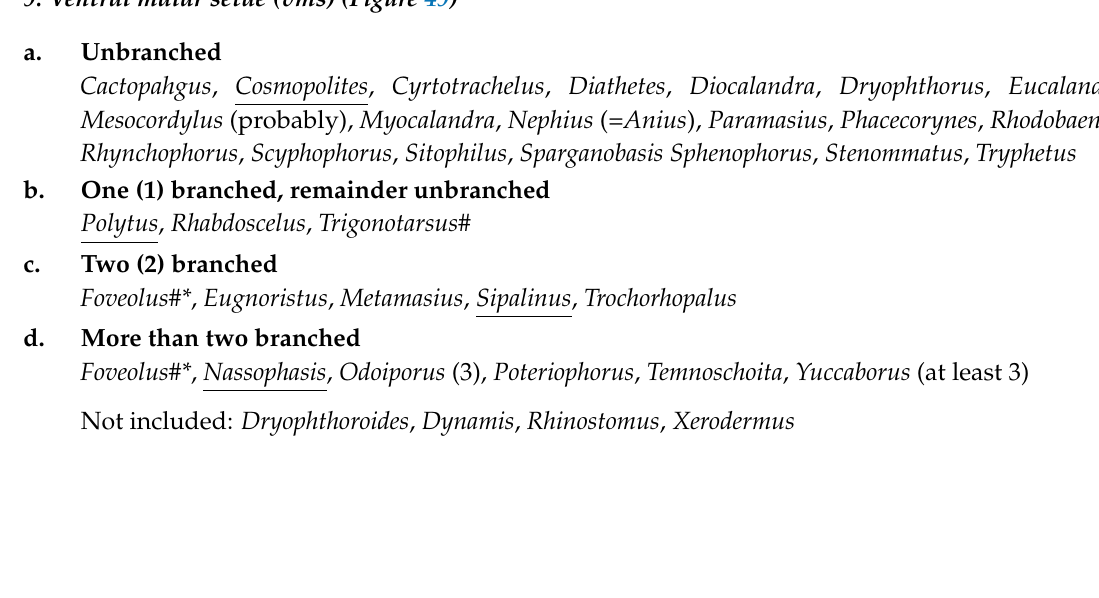
Figure 48. Mala and maxillary palp, larva, dorsal view: ( a ) Rhodobaenus ; ( b ) Diocalandra ; ( c ) Eucalandra; ( d ) Poteriophorus; ( e ) Temnoschoita; and ( f ) Sipalinus . 9. Ventral malar setae (vms) (Figure